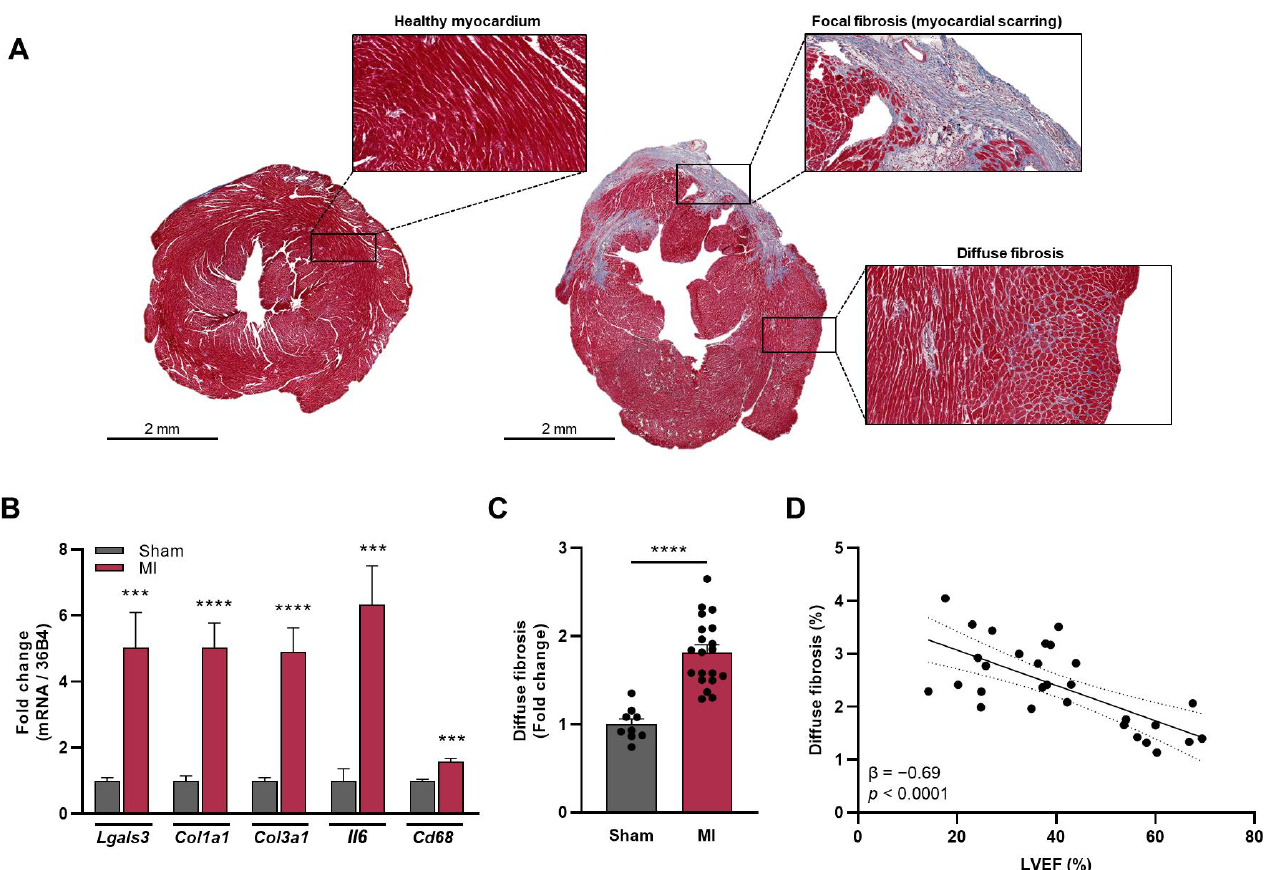
Figure 1. ( A ) Representative images of Masson’s trichrome-stained cardiac tissue sections of C57Bl/6J background mice 6 weeks post-MI, and their sham-operated counterparts. The image details represent a healthy myocardium, focal fibrosis and diffuse fibrosis. ( B ) Cardiac gene expression of genes involved in fibrosis and immune infiltration in sham-operated mice ( n = 9) and mice 6 weeks post-MI ( n = 20), depicted as fold change compared to sham. ( C ) Percentage of diffuse fibrosis of the non-infarcted myocardium in sham-operated mice ( n = 9) and mice 6 weeks post-MI ( n = 20), quantified from Masson’s trichrome-stained images and depicted as fold change compared to sham. ( D ) Association between diffuse fibrosis and cardiac function. *** p < 0.001, **** p < 0.0001. Cd68 , cluster of differentiation 68; Col1a1 , collagen type I alpha I chain; Col3a1 , collagen type III alpha I chain; Il6 , interleukin-6; Lgals3 , galectin-3; MI, myocardial infarction.